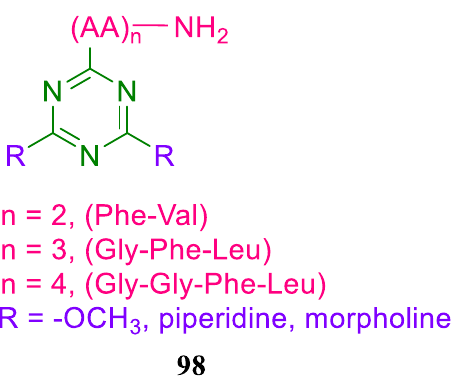
Figure 79. Dipeptides/tetrapeptides conjugated to s-triazine analogues.